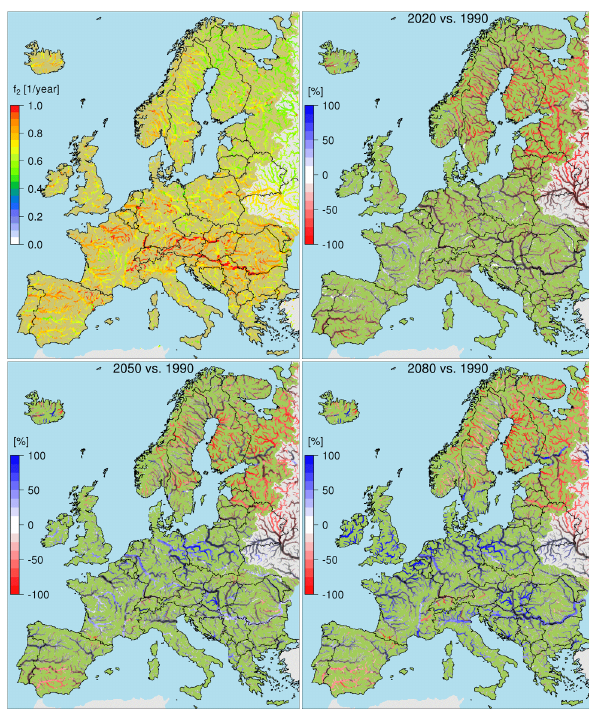
Figure 7. Average frequency of peak flow events with return periods larger than 2 years. Baseline (top left) and relative change for the three future time slices. Data points with CV > 1 are greyed out.